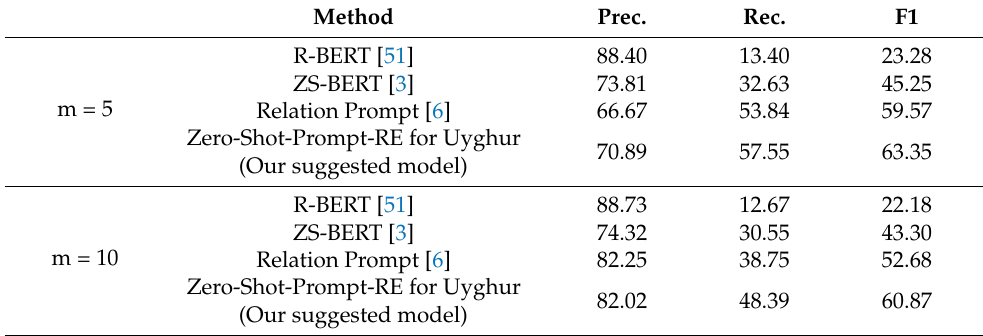
Table 6. Results for our suggested method in Uyghur Zero-Shot-Prompt-Relation Extraction.